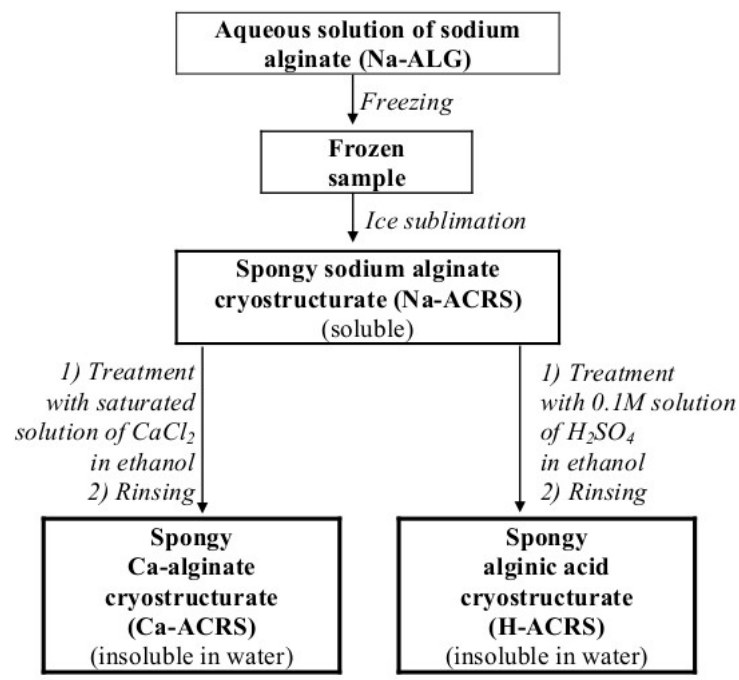
Figure 1. Schematic diagram of the preparation of Ca-alginate and alginic acid cryostructurates.